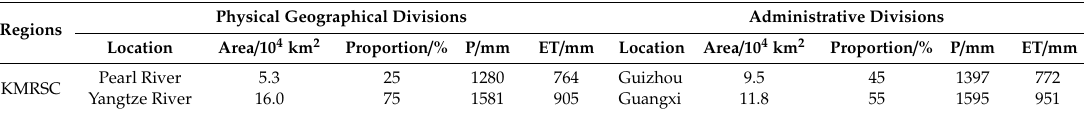
Figure 1. Geographical location of KMRSC.